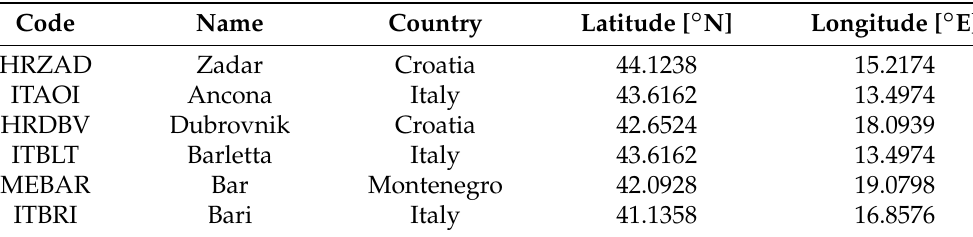
Table 6. International codes and geographical coordinates of the seaports considered in Figure